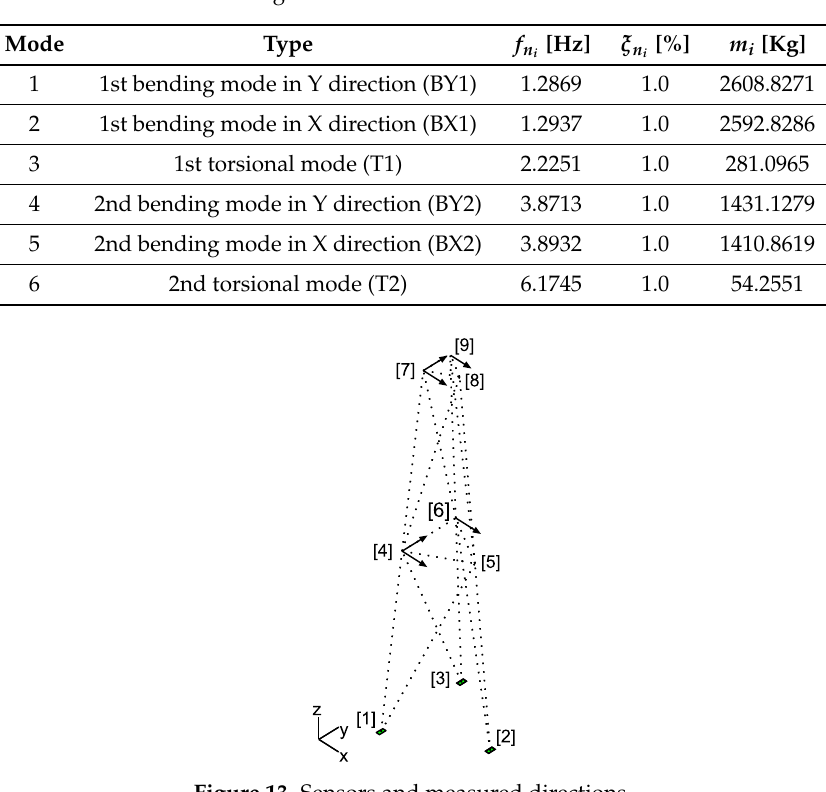
Table 7. Modal configurations of the FE model of the lattice structure.